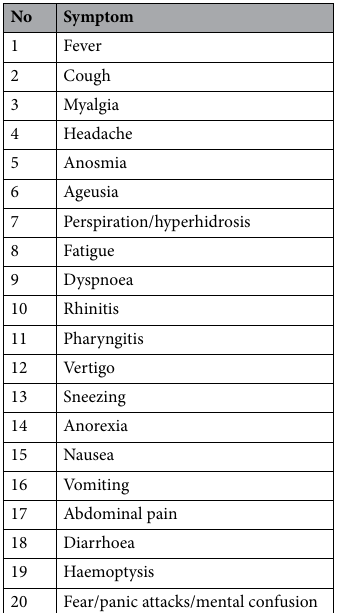
Table 1. Symptoms of COVID-19 taken into account for calculating subjective symptomatic score (the indicator showing subjective perception of the disease by a patient or qualitative clinical observations). Subjective symptomatic score runs from 0 to